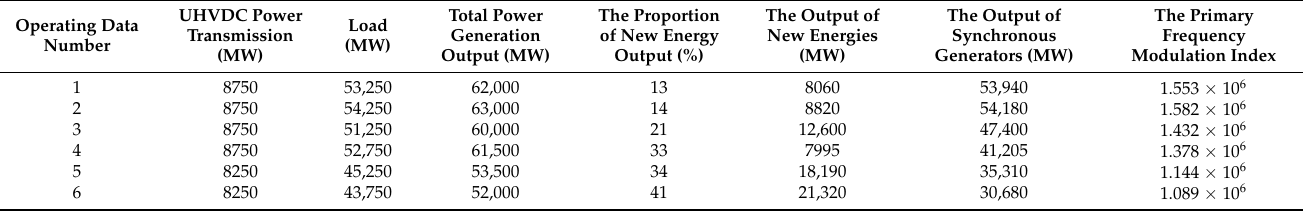
Table 2. The primary frequency modulation index at different operating